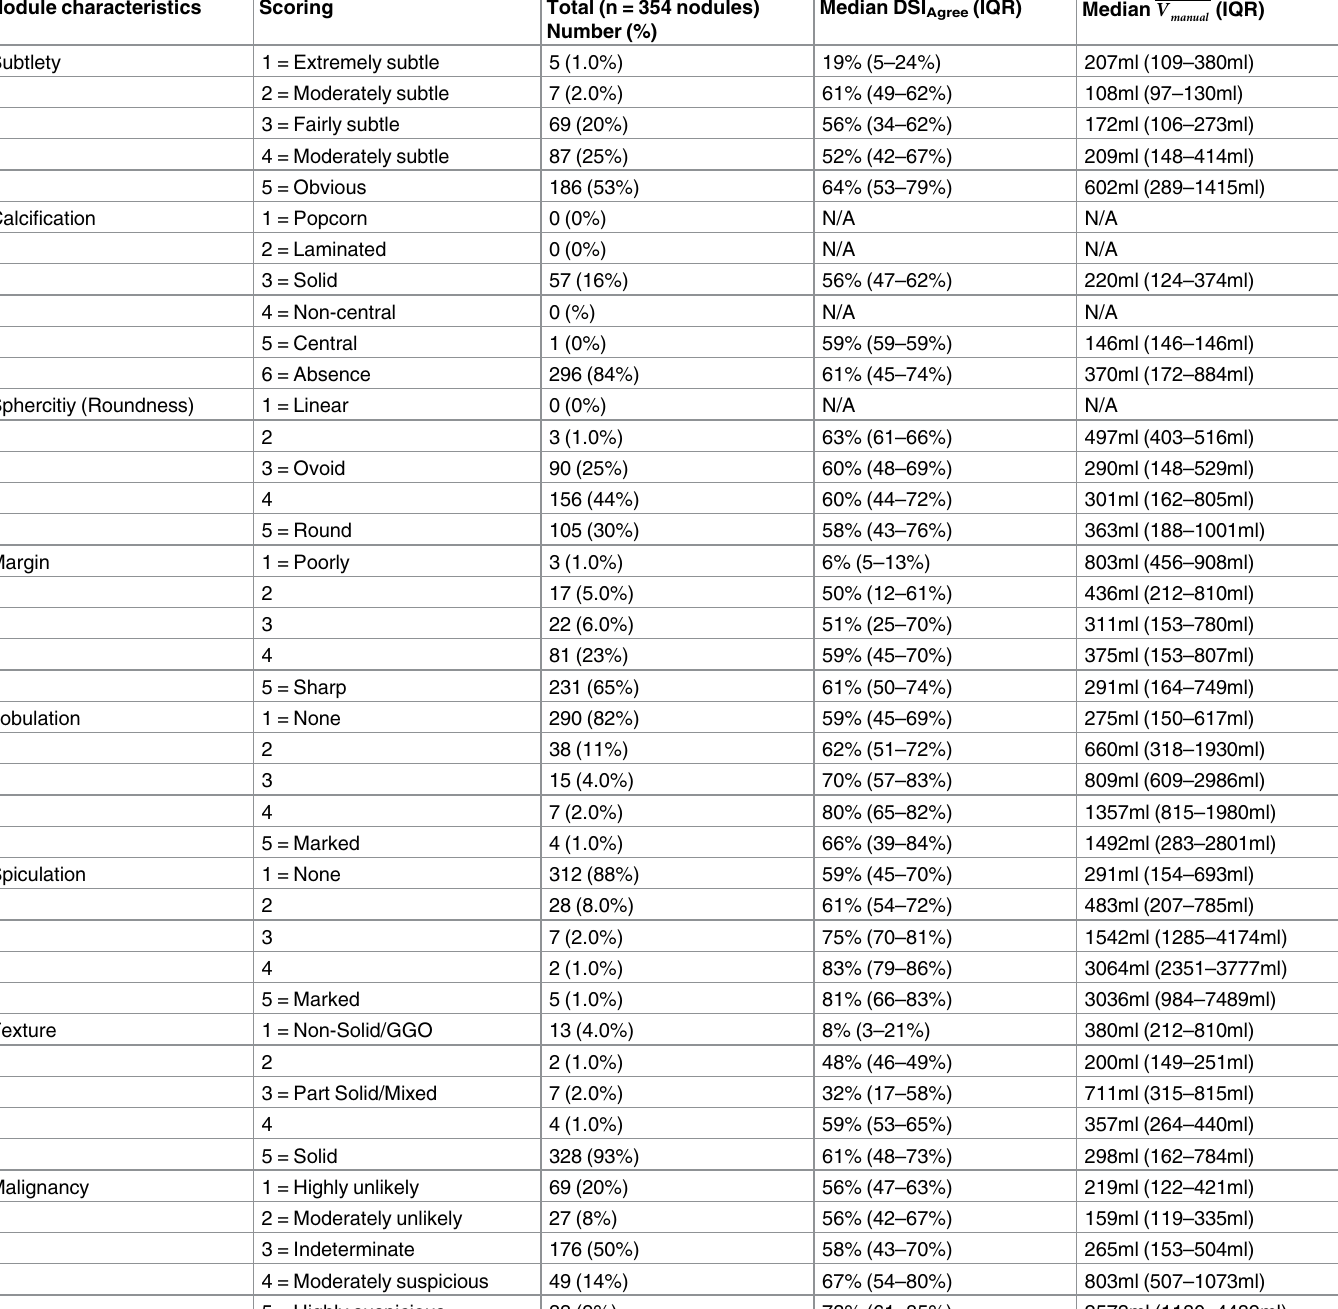
, median DSI Agree and their correspondinginterquartile ranges (IQR) for each nodule